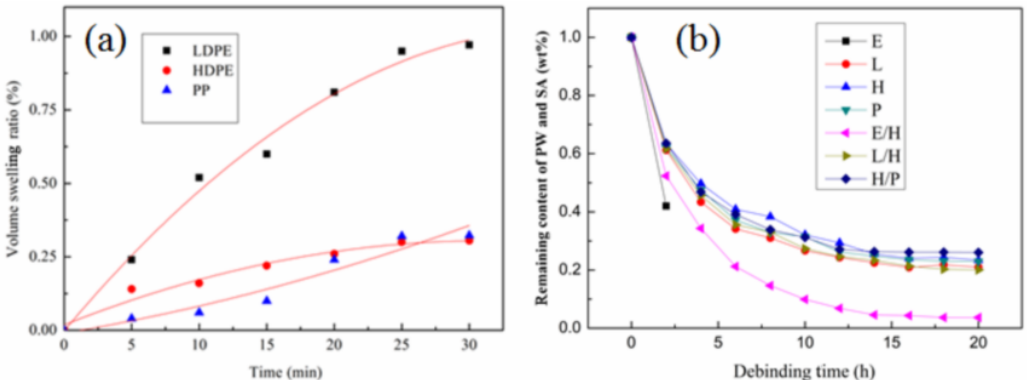
Fig. 7 (a) Volume swelling ratio of LDPE, HDPE, and PP in kerosene at 60 ℃ ; (b) effect of different backbone binders on weight loss of PW and SA at 60 ℃ for various immersion